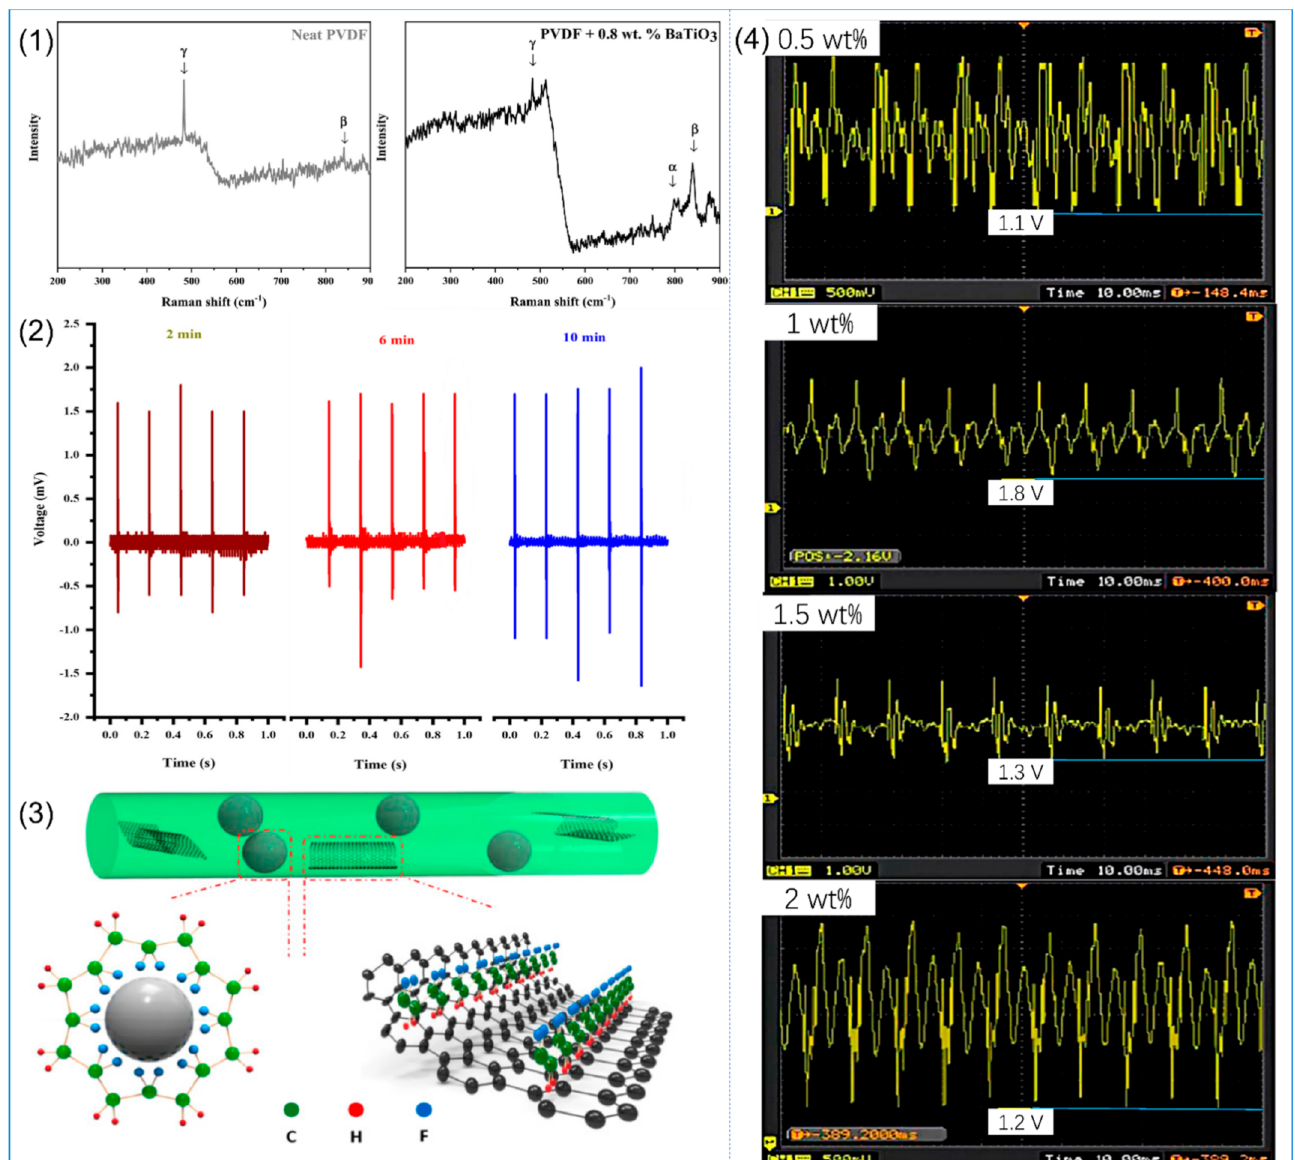
Figure 6. ( 1 ) Raman spectroscopy results of pure PVDF and PVDF containing 0.8 wt% BaTiO 3 . Reprinted with permission from Ref. [117], copyright 2021, Elsevier. ( 2 ) Voltage curve of PVDF − BatiO 3 − Ag composite as a function of time. Reprinted with permission from Ref. [117], copyright 2021, Elsevier. ( 3 ) Schematic diagram of modified nanographene to promote β − phase generation. Reprinted with permission from Ref. [111], copyright 2021, MDPI. ( 4 ) the piezoelec- tric signals of the fiber membrane when different amounts of modified nanographene were added. Reprinted with permission from Ref. [111], copyright 2021,